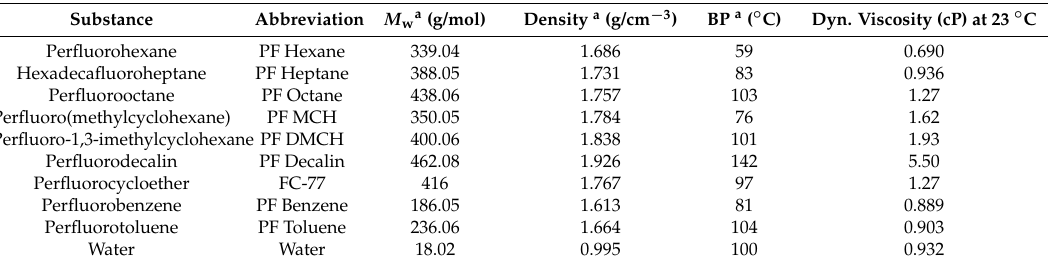
Table 2. Liquids used in this work and their physical data.